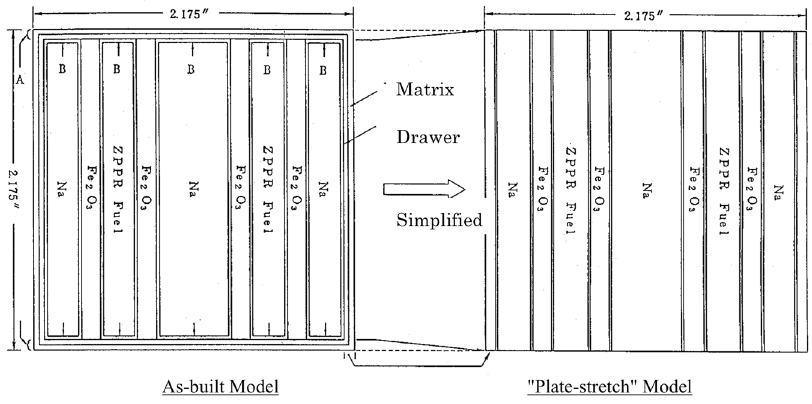
Figure 6. Plate-stretch simplification of drawers in ZPPR